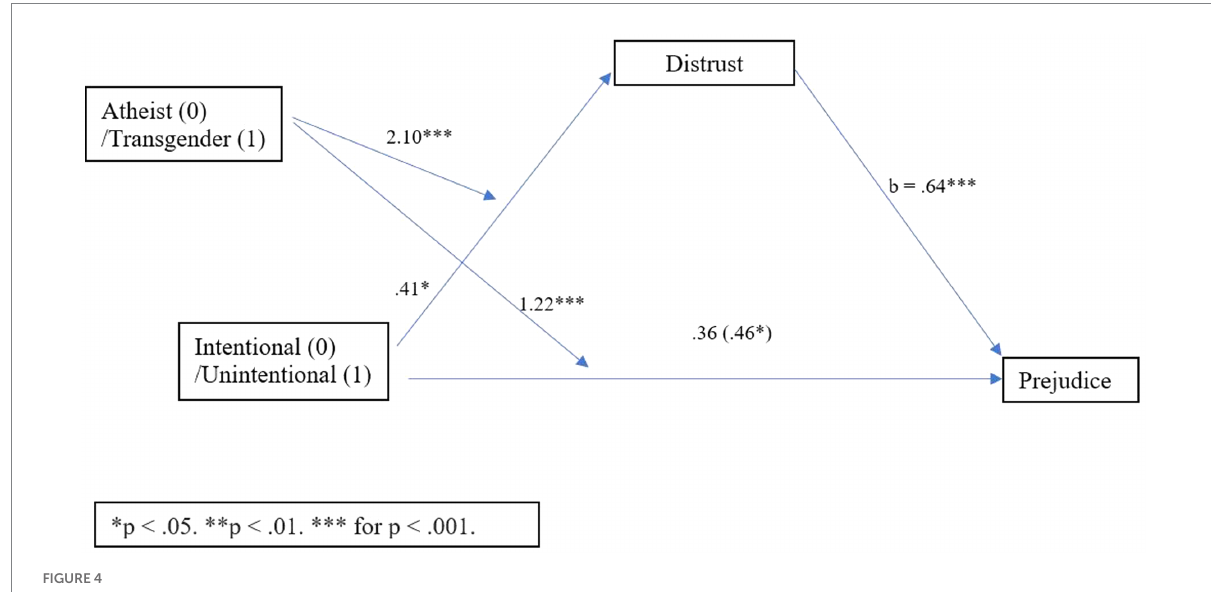
FIGURE 4 Process Model 8 moderated mediation with distrust Study